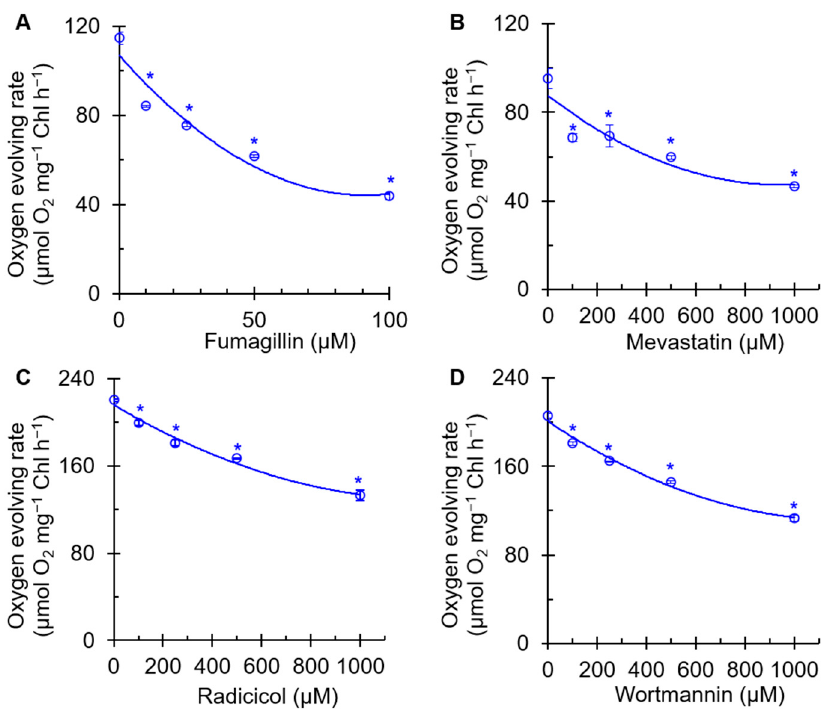
Figure 2. Effects of four mycotoxins, fumagillin ( A ), mevastatin ( B ), radicicol ( C ), and wortmannin ( D ), on oxygen evolving rate of C. reinhardtii cells. H 2 O and p-phenylenediamine were the electron donor and acceptor, respectively. Data shown are mean values ± SE of three biological replicates. * indicates significance at p < 0.05.